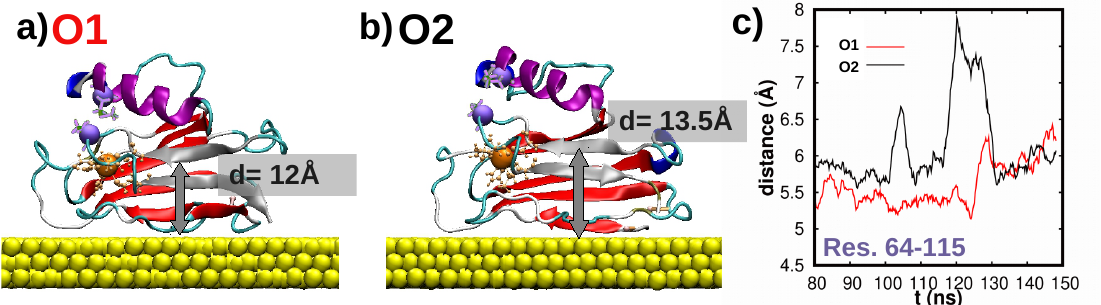
Figure 8. Structural differences between O1 and O2 equilibrium adsorption configurations for wild-type Azurin. Final snapshots obtained for the ( a ) O1 and ( b ) O2 orientations. The representation used is the same as in Figure 5. The β − sheets near the α − helix (S7 and S8 β − sheets , see Figure S9) [16] are highlighted in gray. The distance between these β − sheets and the Au(111) surface is also shown. The distance between the Cu center and the end atom of the α − helix , both highlighted via a Van-der-Waals sphere in both ( a , b ), is represented in the plot shown in ( c ) for both orientations, i.e., O1/O2 in